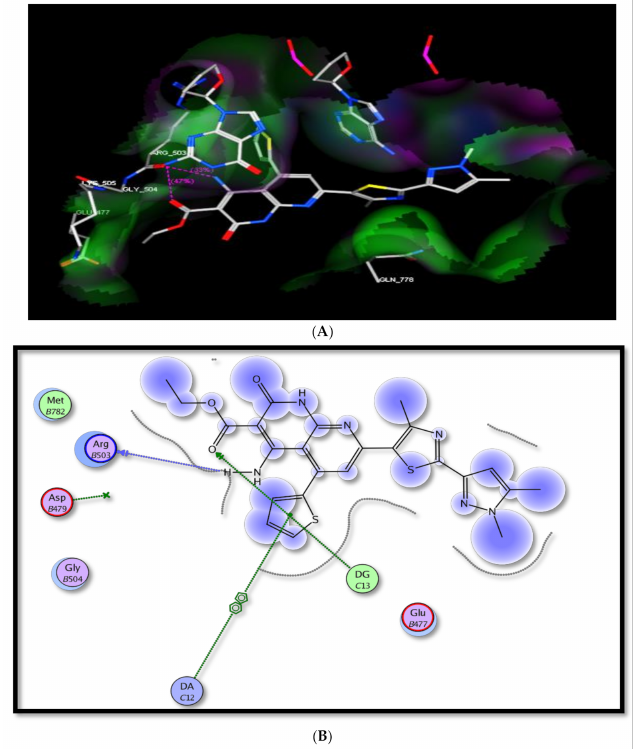
Figure 5. The suggested binding mode of compound 5 within topoisomerase II. ( A ) 3D binding mode within the active site. ( B ) 2D binding mode within Topoisomerase